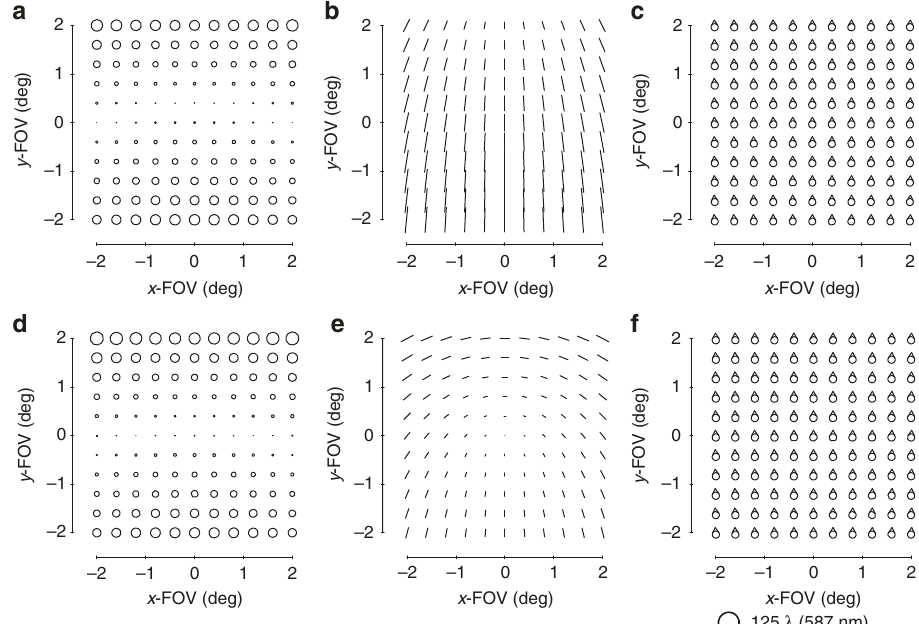
Fig. 3 Zernike-based aberrations FFDs after an astigmatism surface. Full- fi eld displays (FFDs) calculate and plot the magnitude and orientation of a given aberration over a set of points that sample the full FOV. The aberrations of the system shown in Fig. 2 before adding any freeform shapes are shown in the FFDs for a defocus (Z4), b astigmatism (Z5/6), and c coma (Z7/8). The aberrations after the addition of an astigmatism shape to the primary and tertiary mirrors are shown in the FFDs for d defocus (Z4), e astigmatism (Z5/6), and f coma (Z7/8). Other aberrations are negligible when plotted at this scale, which is indicated below